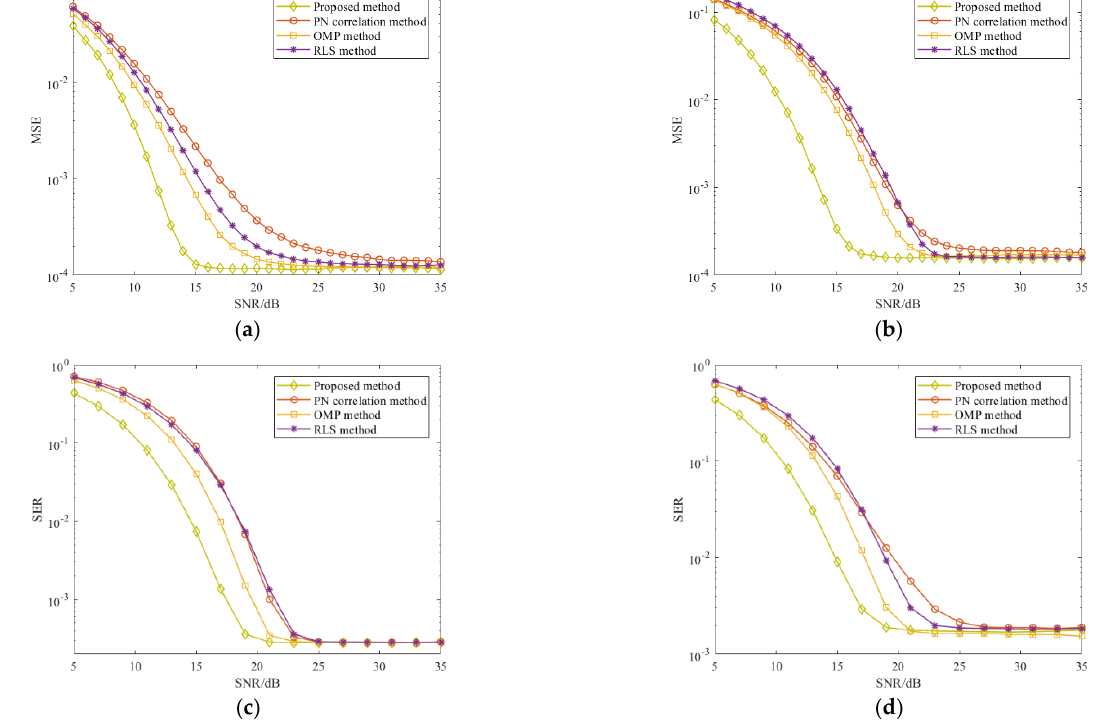
Figure 11. MSE and SER performance of four CIR estimation methods in different channel: ( a ) MSE performance in Brazil A; ( b ) MSE performance in COST207; ( c ) SER performance in Brazil A; ( d ) SER performance in COST207.